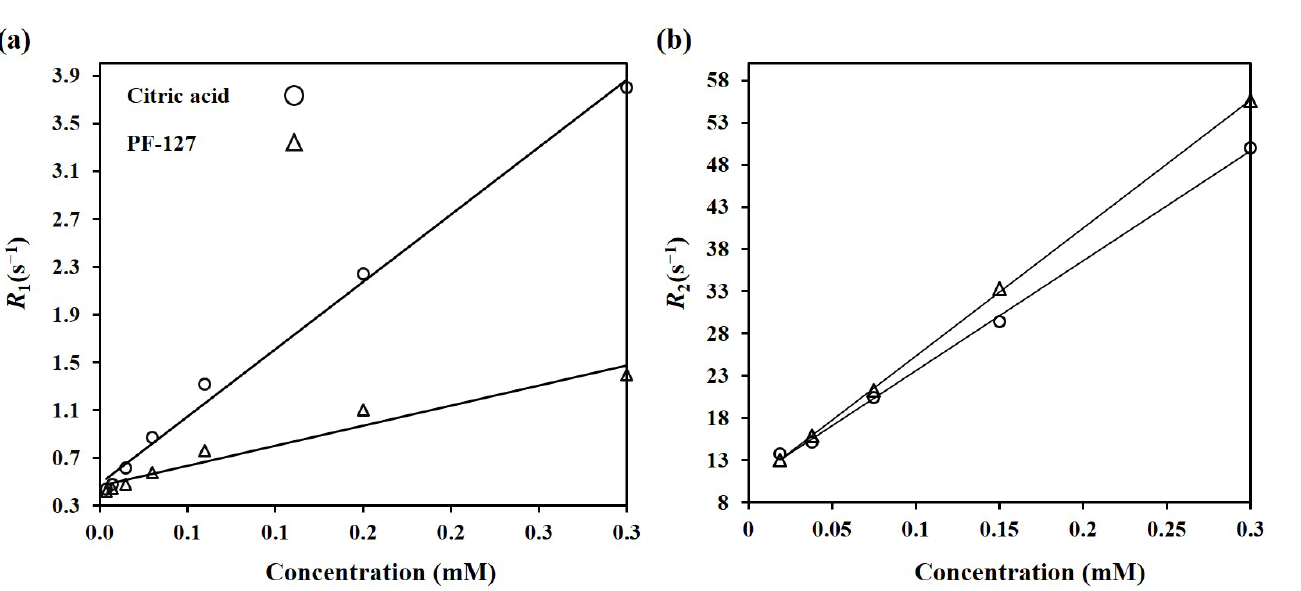
Figure 9. The variation in the relaxation rates ( a ) R 1 and ( b ) R 2 as a function of concentration for citric-acid- and pluronic F-127-coated Mn 0.6 Zn 0.4 Eu 0.15 Fe 1.85 O 4 .